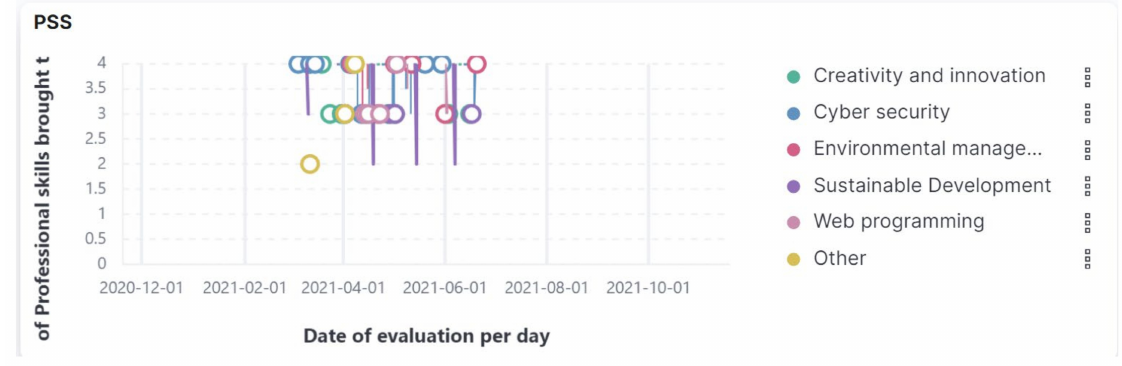
Figure 10. Responsive dashboard presenting Professional Student Skills